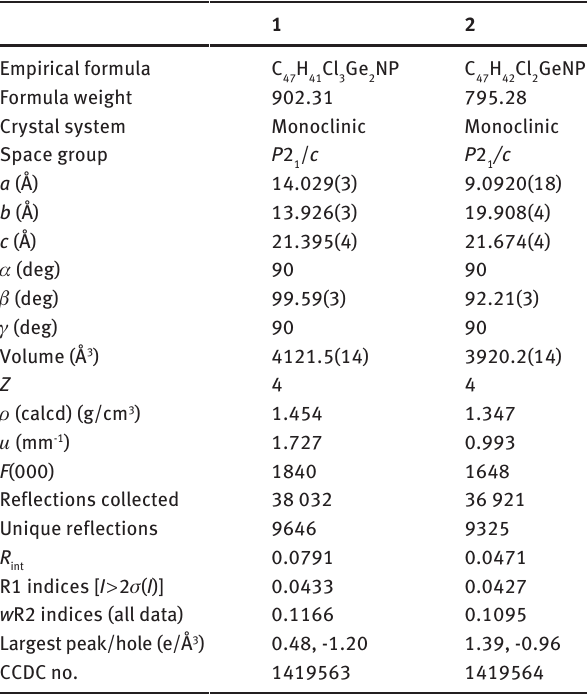
Table 1: Summary of crystallographic data for compounds 1 and 2